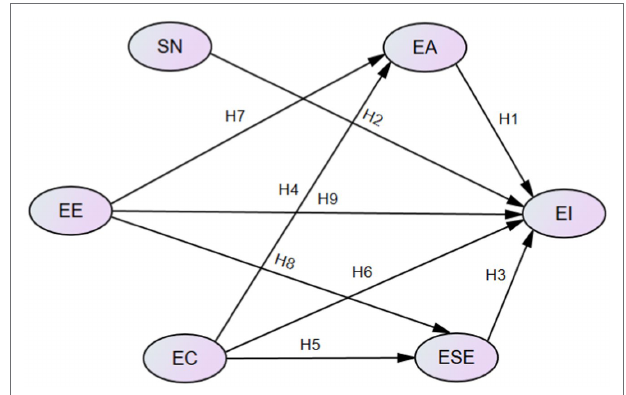
FIGURE 1 | Conceptual framework. SN = subjective norms, EA = entrepreneurial attitude, ESE = entrepreneurial self-efficacy, EI = entrepreneurial intention, EC = emotional competency, EE = entrepreneurial